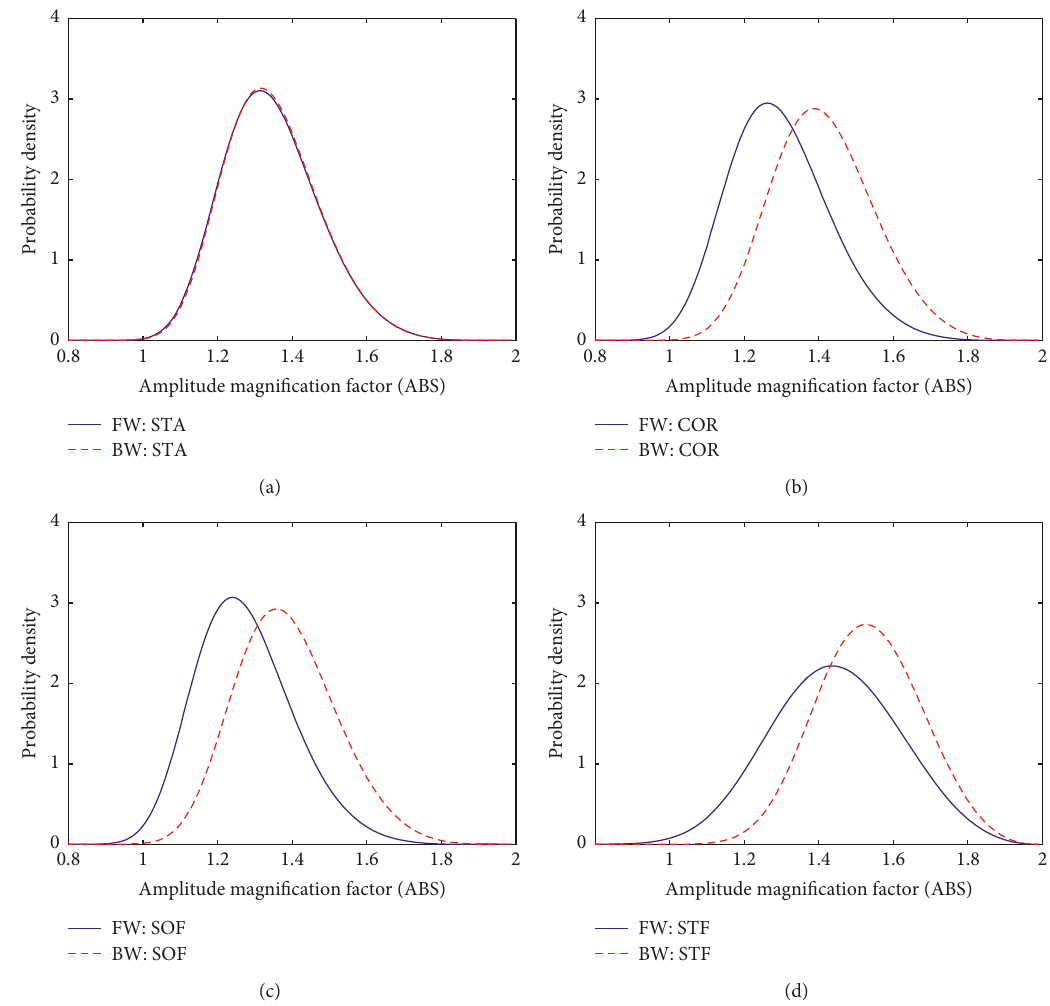
Figure 19: Comparison on the probability densities versus absolute AMF under the action of backward and forward traveling wave excitations of 3EO: (a) case STA, (b) case COR, (c) case SOF, and (d) case STF. 2000 mistuning patterns generated by uniform distribution of mean 0 and standard deviation 2.0% are used in Monte Carlo